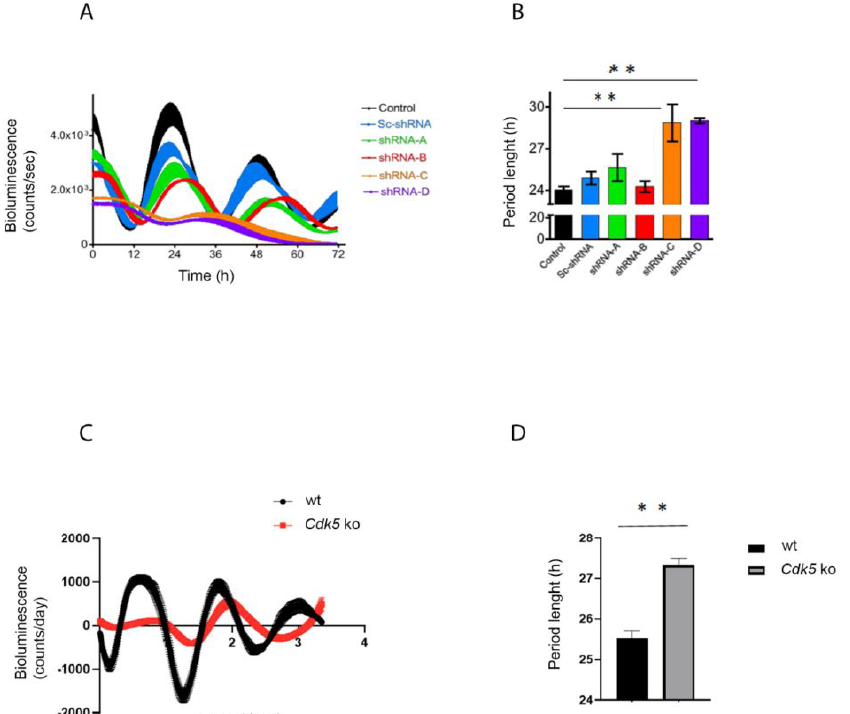
Figure 1. CDK5 affects the circadian clock. ( A ) NIH 3T3 cells were transfected with different shRNA against Cdk5 . Forty-eight hours after the silencing, cells were transfected with an Arntl luc reporter construct and synchronized with 100 nM dexamethasone. The bioluminescence was recorded over several days. ( B ) The period length was quantified, and statistical analysis was performed. The results showed that silencing of Cdk5 could prolong the period length. Quantification of three independent experiments ( n = 3, mean ± SD) was performed. One-way ANOVA with Bonferroni’s post-test, *: p < 0.001. ( C ) Wild-type and Cdk5 ko cells were transfected with an Arntl luc reporter